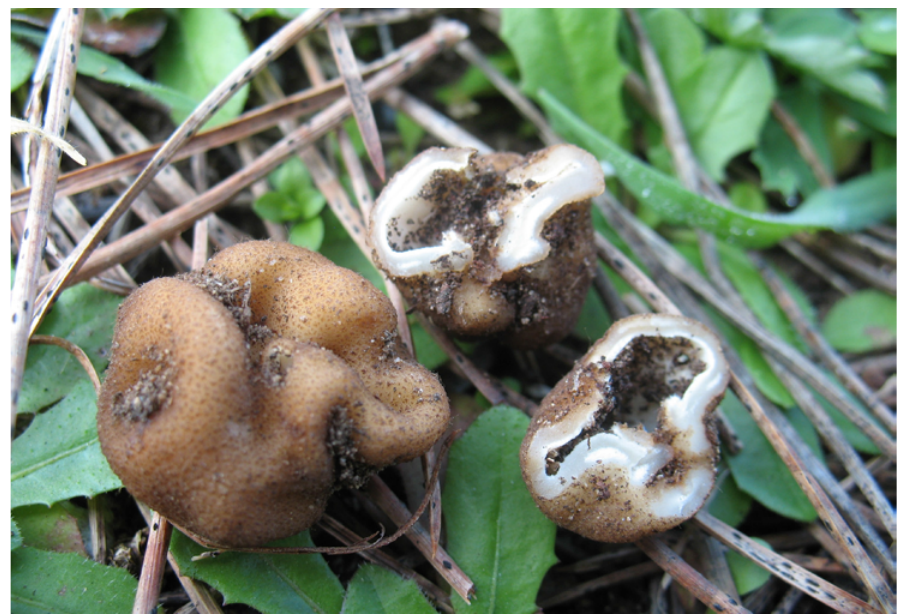
2007.Fig. 1. Hydnocystis clausa found under Pinus pinea in warm, sandy